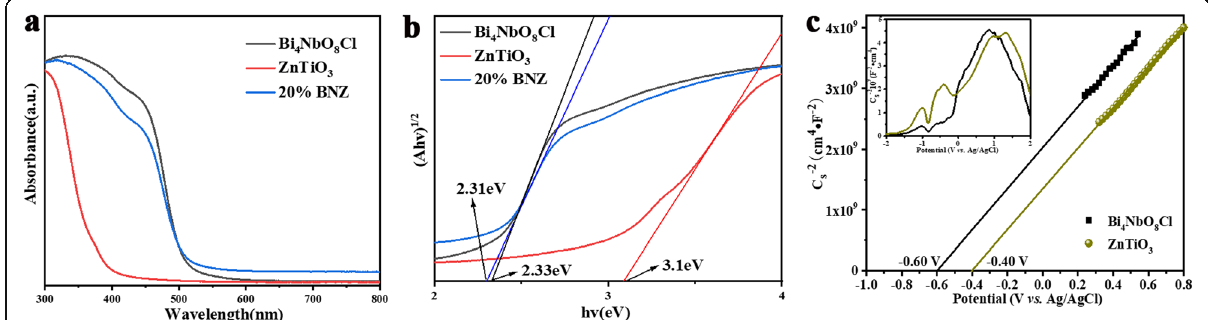
Fig. 5 a DRS spectra of ZnTiO 3 , Bi 4 NbO 8 Cl, and 20% BNZ sample. b Tacus ’ s curves of ZnTiO 3 , Bi 4 NbO 8 Cl, and 20% BNZ sample. c Mott – Schottky curves of ZnTiO 3 and Bi 4 NbO 8 Cl